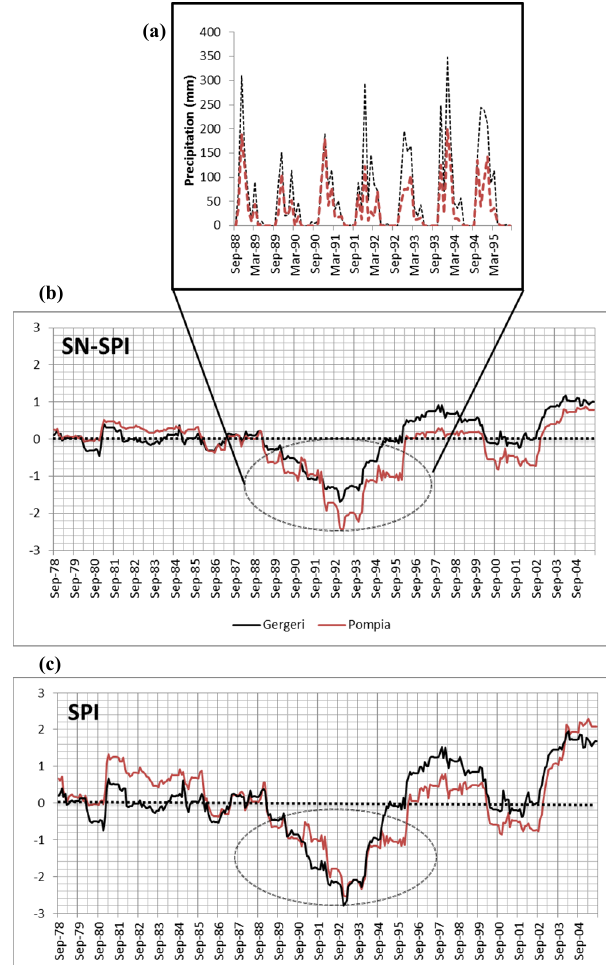
Fig. 4. (a) Monthly precipitation time series for drought events (b) 48-month time scale SN-SPI and (c) SPI for two representative stations of north-western Crete based on the period 1974–2005.